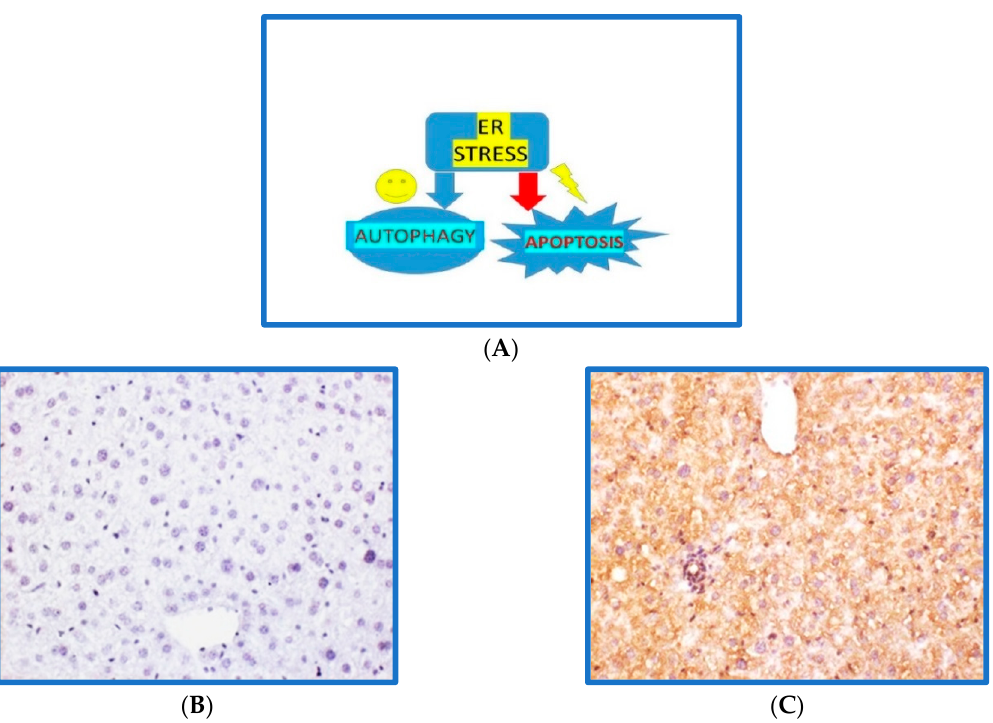
Figure 2. Endoplasmic reticulum (ER) stress response in hepatocytes triggered by a hypercaloric fat rich diet. ( A ) ER stress/ unfolded protein response (UPR) may be a short adaptive mechanism able to restore homeostasis by stimulating autophagy, or it may be chronic and detrimental by triggering apoptosis, or pyroptosis, a peculiar caspase 1-dependent inflammatory cell death. ( B ) Caspase 1 immunostaining negligible in C57BL6/J mice liver fed a standard rodent diet for 16 weeks; ( C ) Caspase 1 immunostaining is intense in C57BL6/J mice liver fed an obesogenic high fat diet for 16 weeks. Original magnification = 200× .